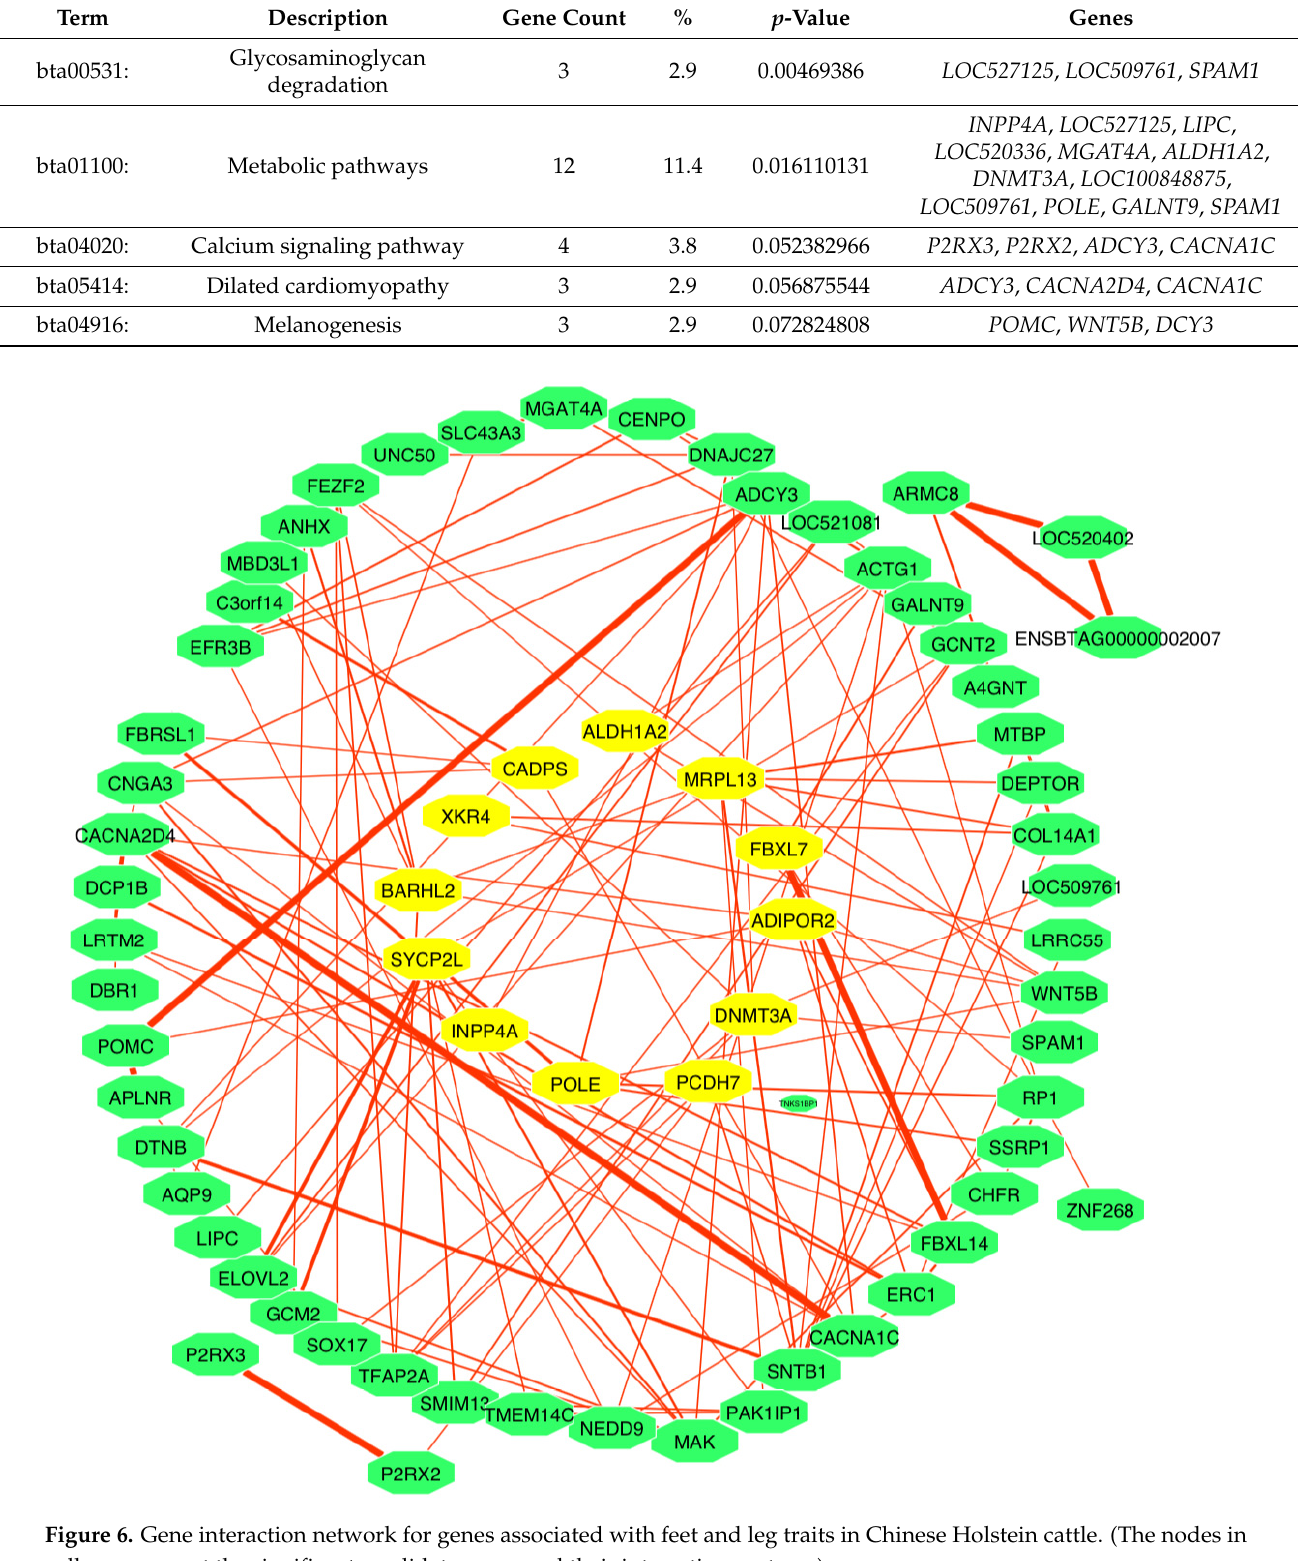
Table 4. KEGG analysis for the regional candidate genes with genome-wide significant association.